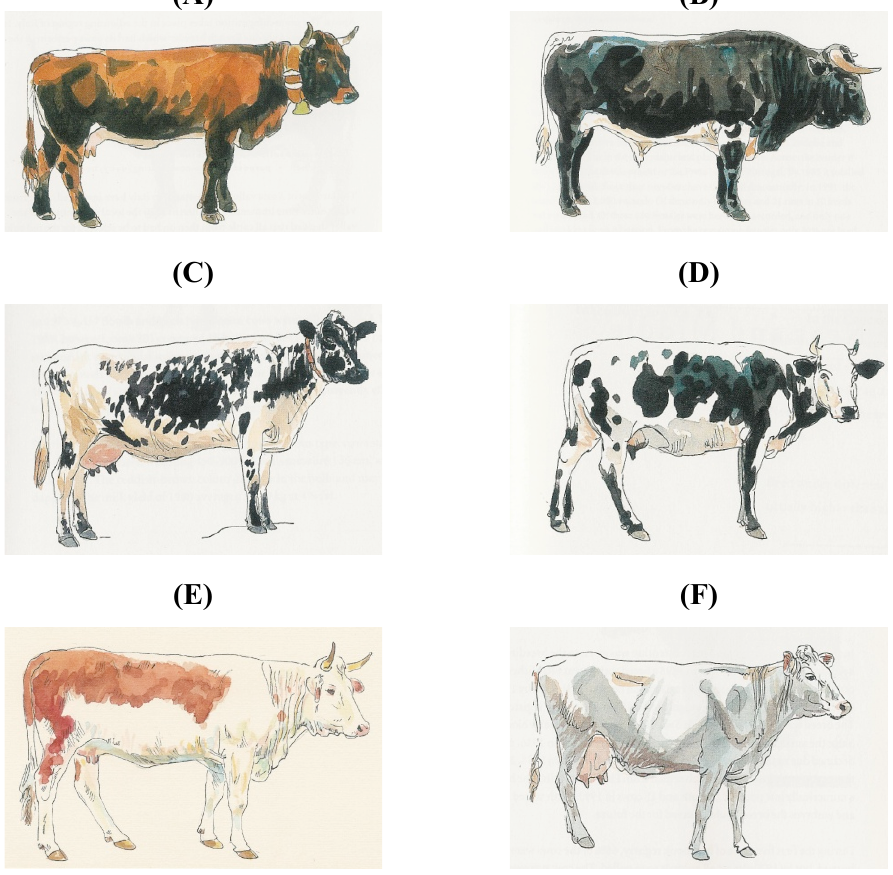
A few breeds do not even have the color of the group into which they are included. Subgroup 4.4., Scandinavian Red, includes the multicolored Icelandic cattle, the yellow-brown West Finncattle and Estonian Native, the Norwegian Red (consisting of red-and-whites and black-and-whites) and the red-pied Swedish (Figure 7). - Breeds of the Iberian Red groups (4.6) are as brown as the Iberian Brown cattle (5.4) group. - In subgroup 2.2, Aberdeen-Angus and German Angus are either black or red, while the Australian Murray Grey is dun (brownish